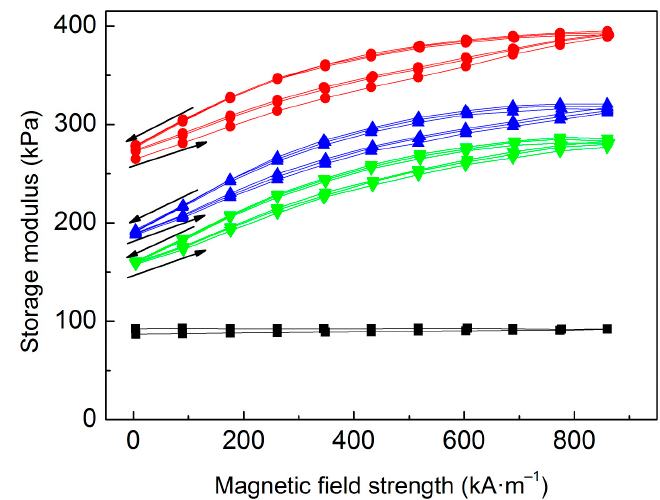
Figure 6. Storage modulus of neat PDMS matrix ( black squares ), and the MREs containing bare CI ( red circles ), CI ‐ g ‐ PHEMATMS ‐ 1 ( blue up ‐ triangles ), and CI ‐ g ‐ PHEMATMS ‐ 2 ( green down ‐ triangles ) particles as a function of applied magnetic field strength.